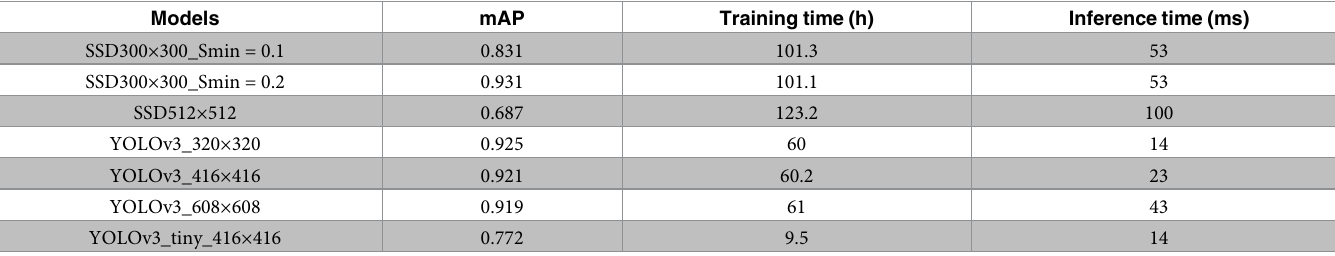
Table 2. Comparison of time consuming using different models. Models mAP Training time (h) Inference time (ms)